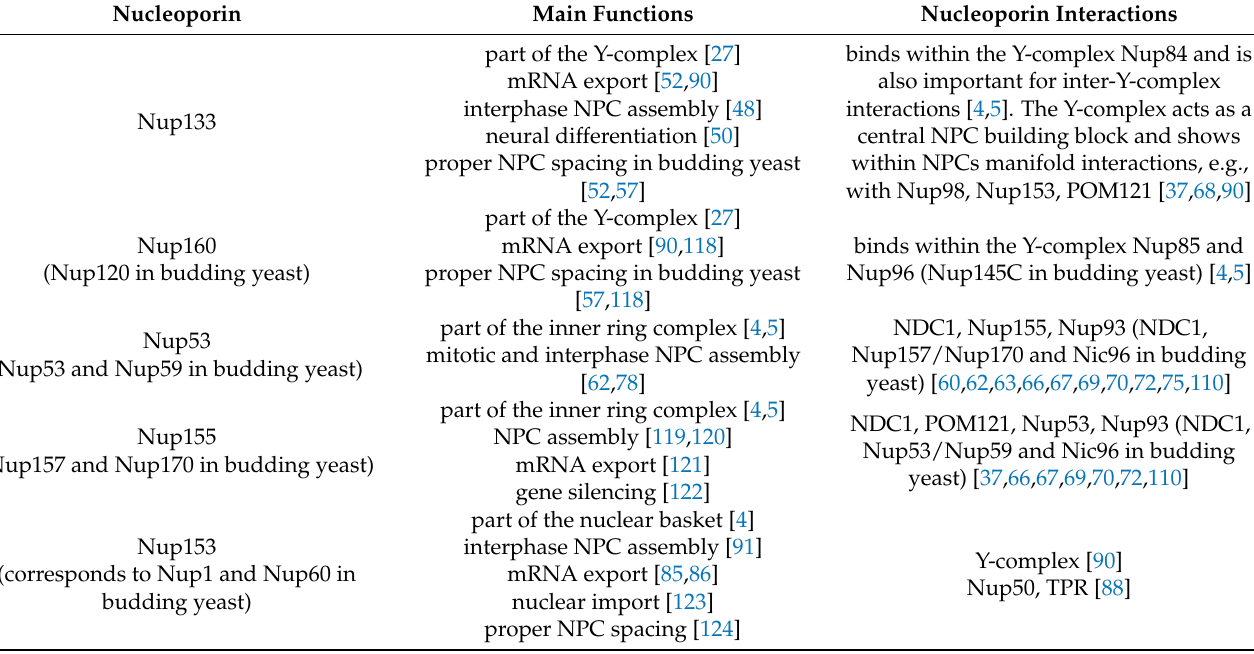
Table 1. Nucleoporins acting as peripheral membrane